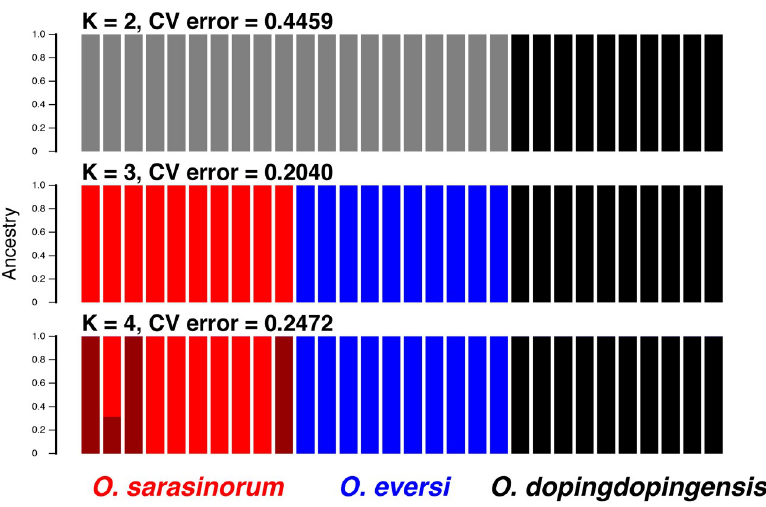
Fig 4. ADMIXTURE results showing K = 2–4 genetic clusters. Analysis was based on 1,487 SNPs among the three species.